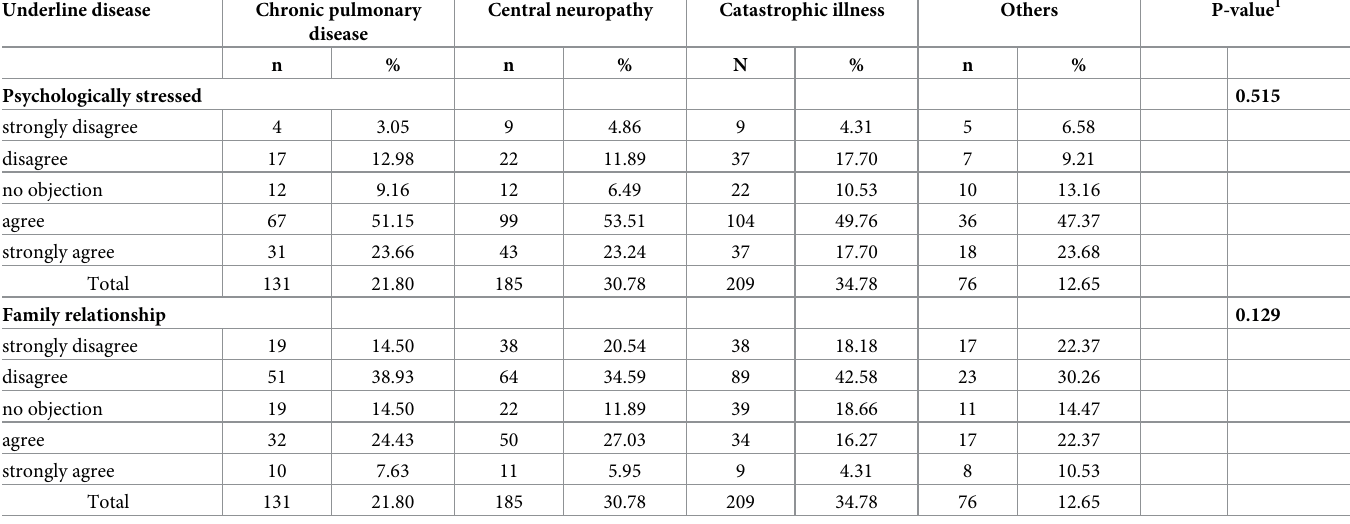
Table 5. Association of underlying diseases of the patients with stress level and family relationship. Underline disease